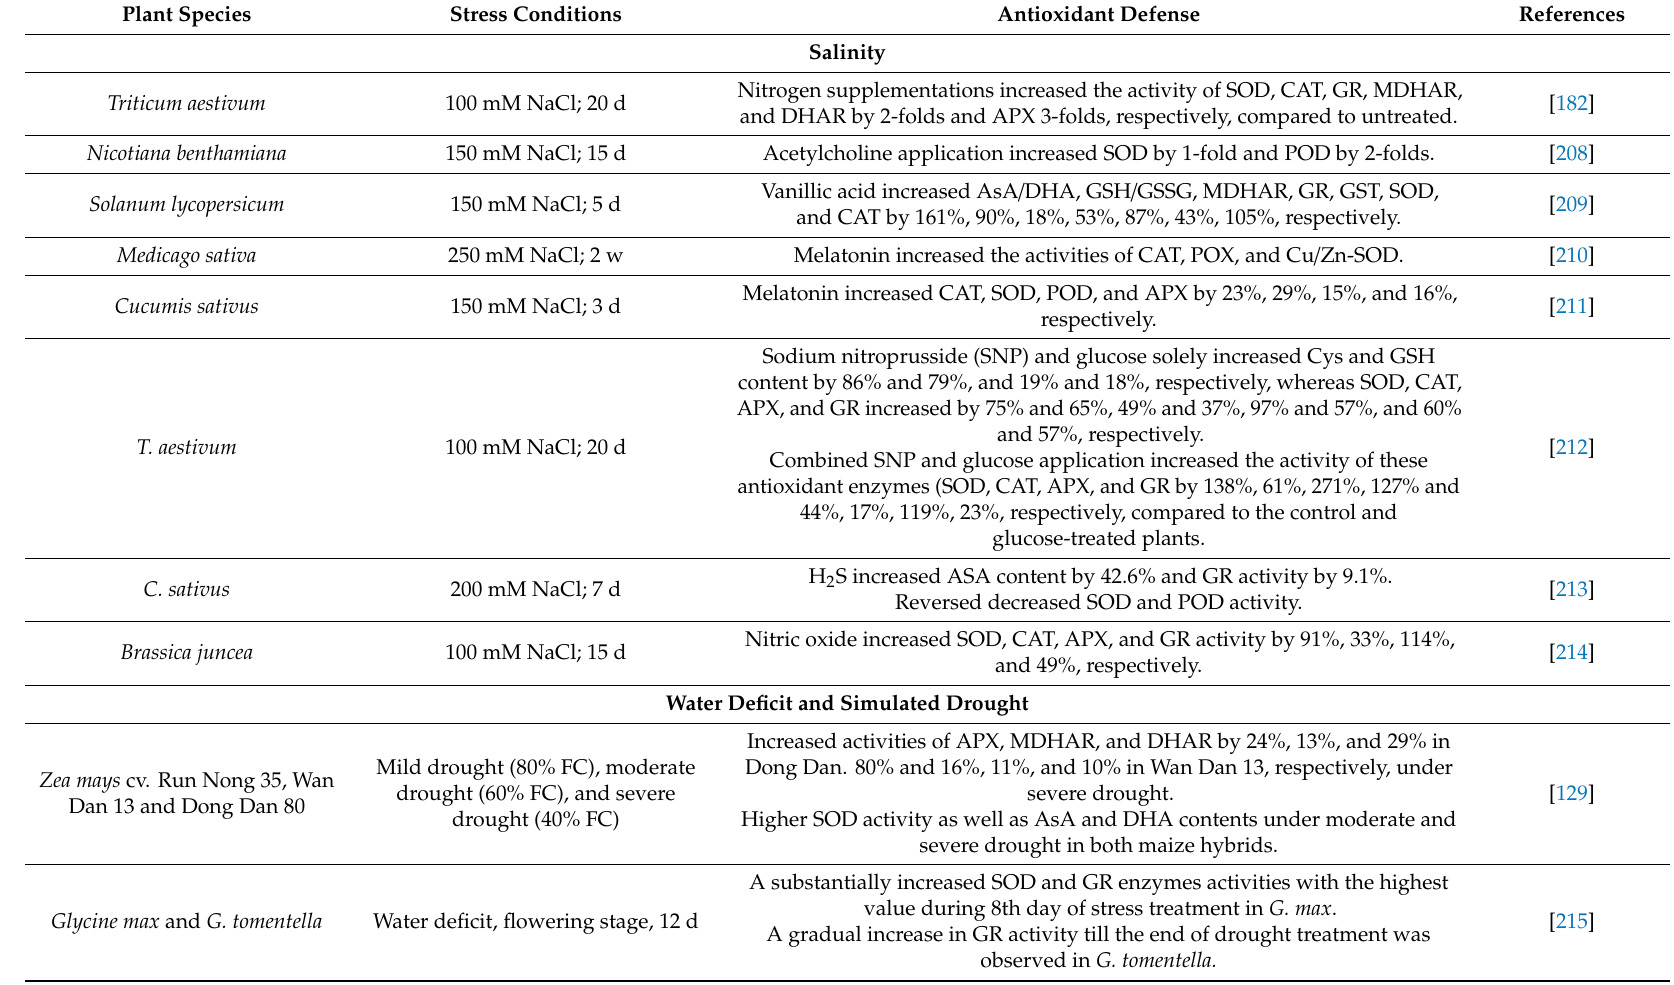
Table 3. Antioxidant defense in plants under di ff erent abiotic stress